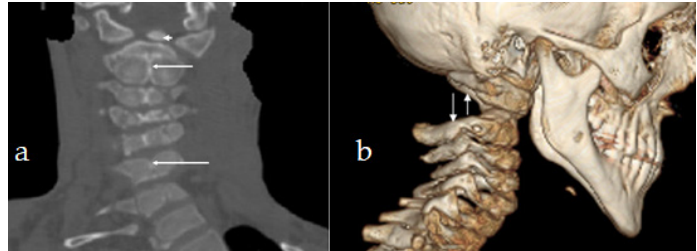
Figure 1. ( a ). Reformatted Coronal CT scan of the cervical spine showed butterfly vertebrae (defective formation), note the detached cephalic part of the odontoid process (arrowhead) in connection with extensive cervical spine synchondrosis causing the mal-development of butterfly vertebrae. ( b ) Reconstruction CT scan of the cervical spine showed atlanto-axial dislocation (arrows).